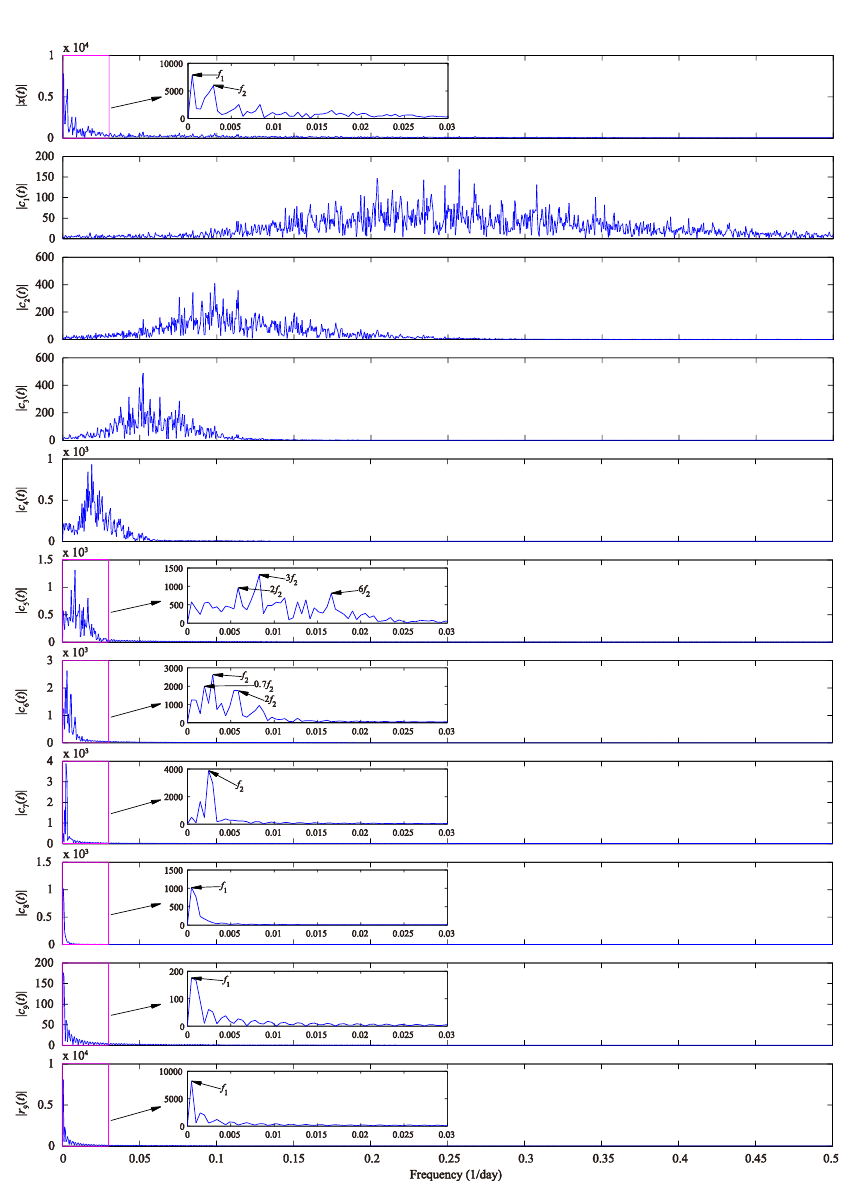
Figure 5. Frequency spectrum of each IMF and residue component using GFT.